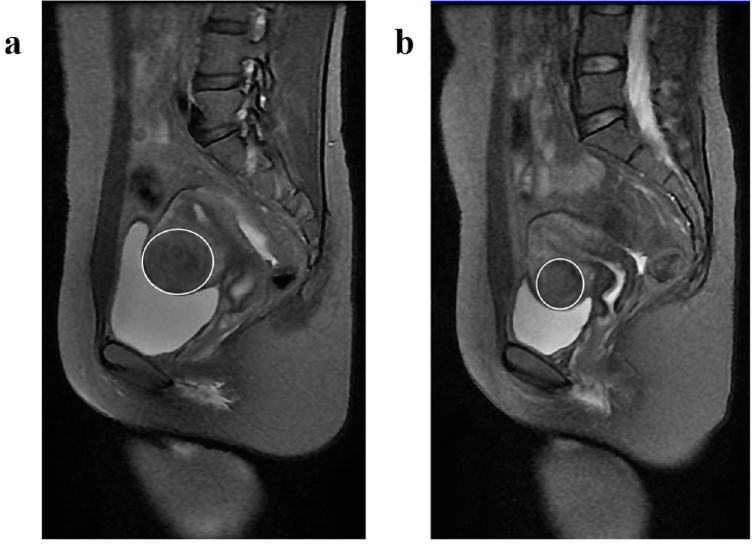
Figure 1. Magnetic resonance images showing the fibroid(white circles) before and after HIFU treatment. ( a ) before HIFU treatment, ( b ) three months after HIFU